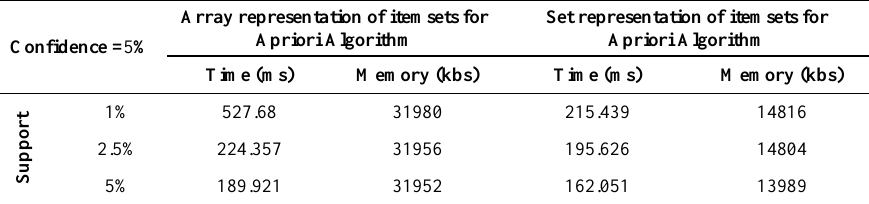
Table 4. Array and set representation of itemsets for Apriori Algorithm with confidence value=5% and Support =1, 2.5, and 5%. Array representation of itemsets for Set representation of itemsets for Apriori Algorithm Apriori Algorithm Confidence = 5 %